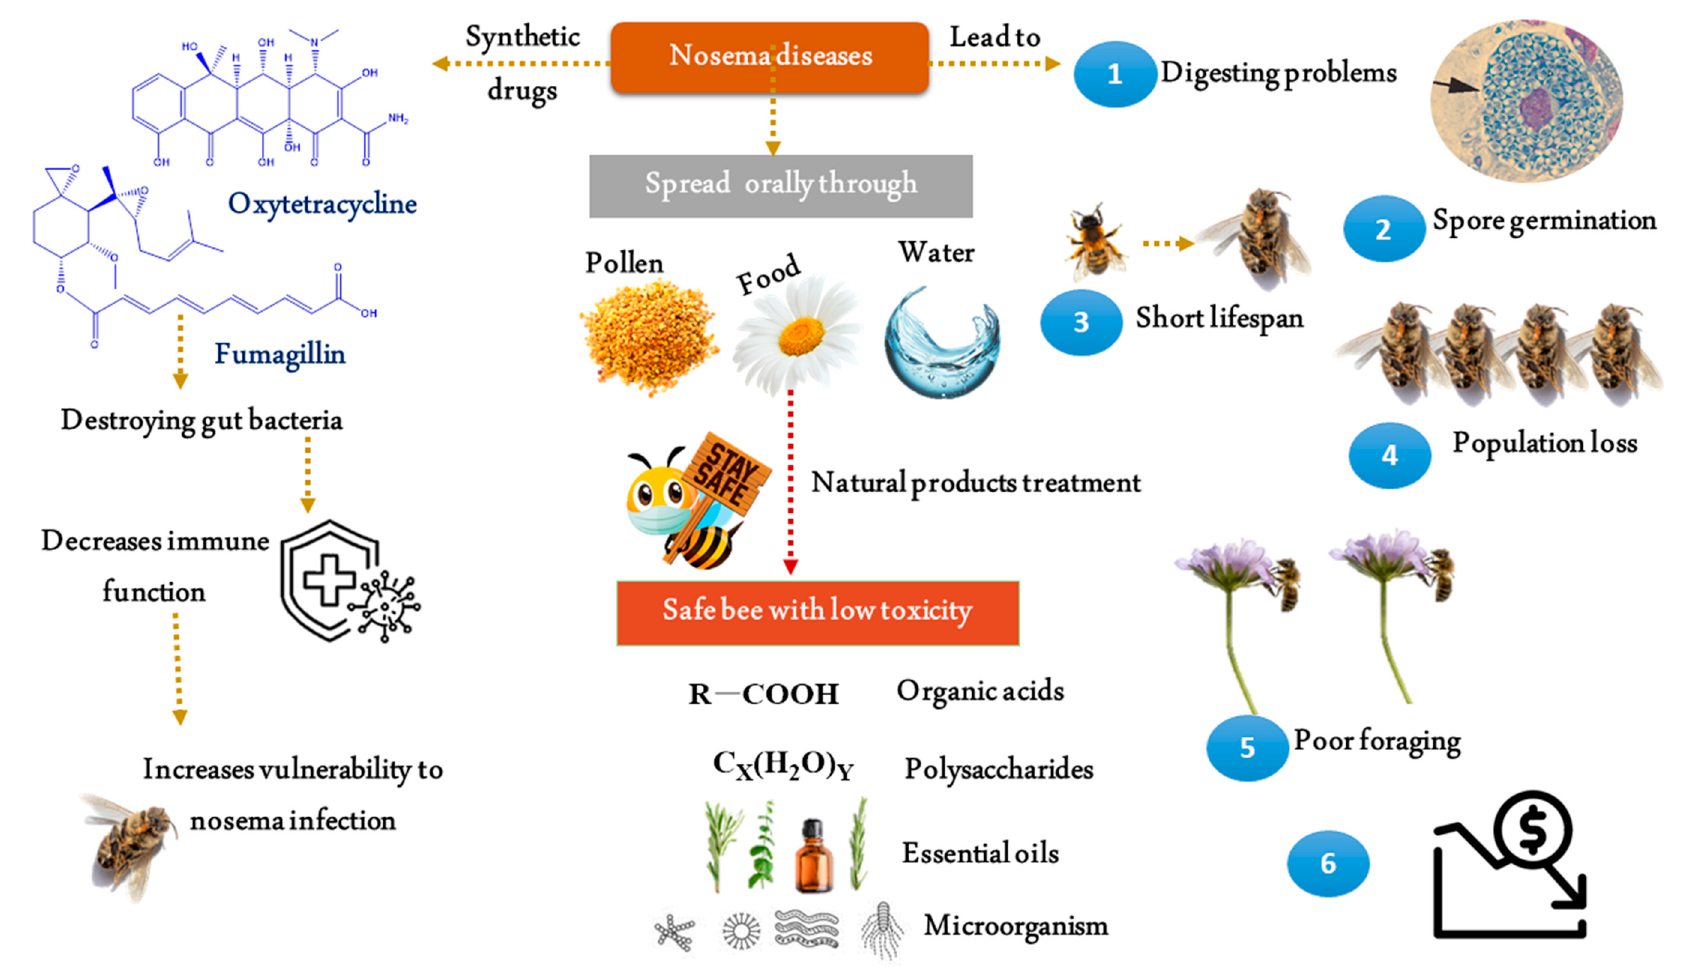
Figure 1. Treatment of nosema diseases in Apis mellifera across synthetic and natural products.